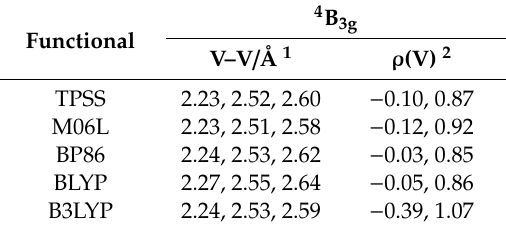
Table 2. V–V bond lengths and Mulliken spin densities for the 4 B 3g state of [V 6 N 6 ] + . Functional